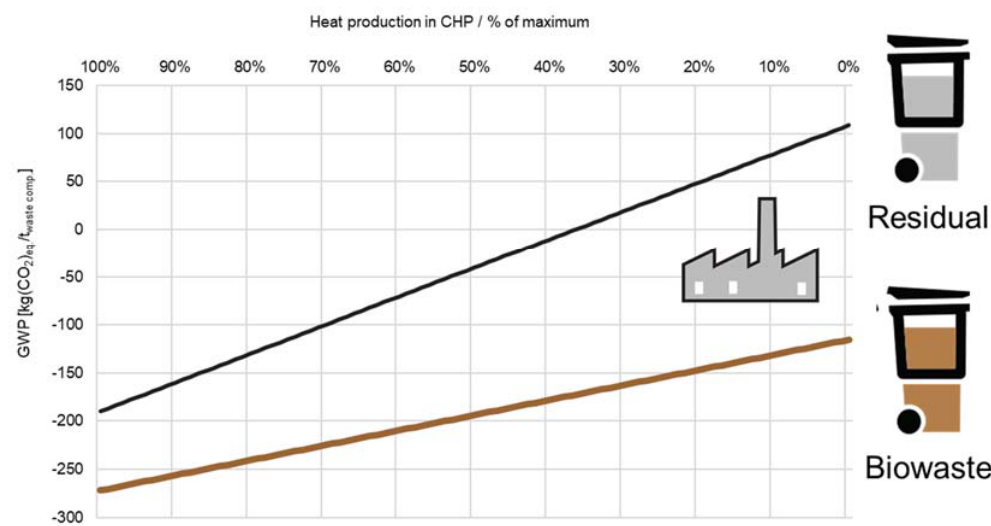
Figure 7. GWP as a function of percentage utilization of heat produced in WtE—the total balance for RES and contribution of its component biowaste (RES-BIO). Table 1. Global warming potential (GWP) of residual waste (RES) in waste-to-energy (WtE) before and after biowaste component